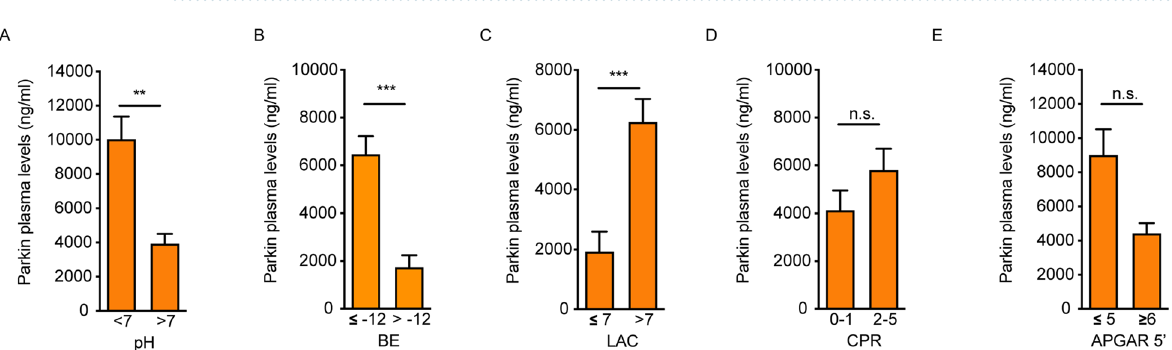
Figure 4. Stratification of Parkin levels in the Group B. Parkin level stratification according to pH ( A ), base excess ( B ), lactates ( C ), CPR ( D ) and Apgar score at 5 min ( E ) in Group